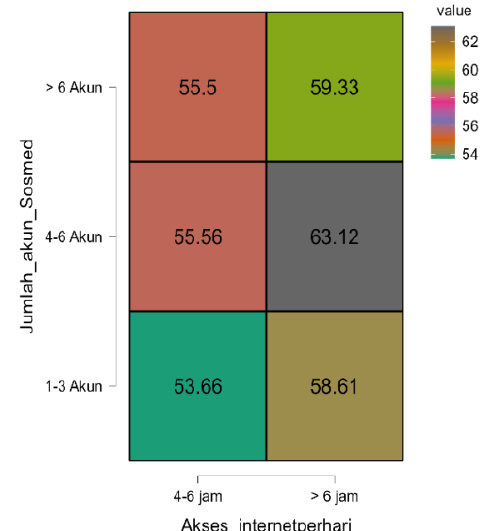
Figure 4. Narcissistic Heatmaps Based on Social Media Use